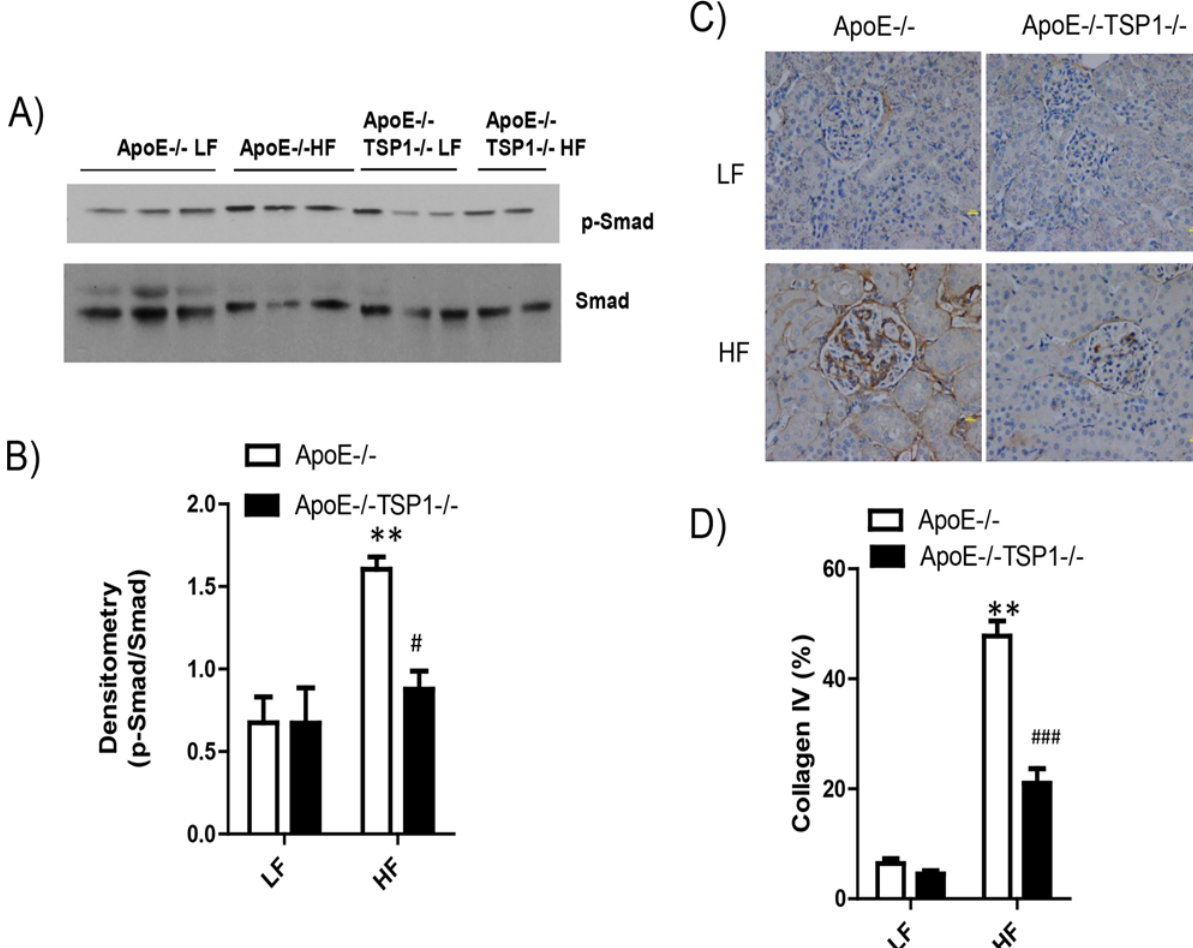
S1 Fig. Photograph of Oil red O staining of frozen kidney sections from ApoE-/-LF and ApoE-/-HF feeding mice (n = 3 mice/group). (TIF) S2 Fig. Photograph of Oil red O staining of frozen kidney sections from ApoE-/-TSP1-/-LF and ApoE-/-TSP1-/-HF feeding mice (n = 3 mice/group).